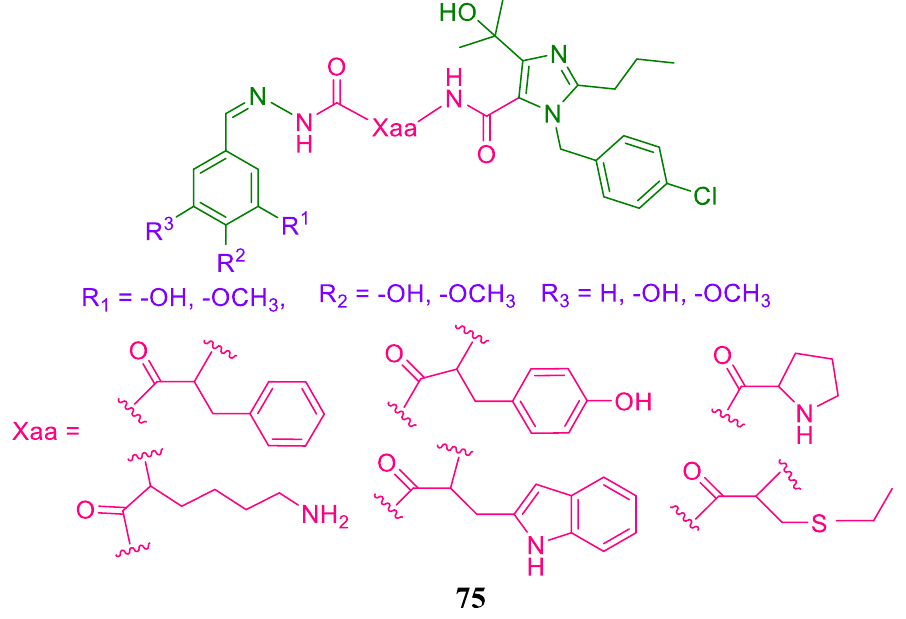
Figure 61. Amino acids – imidazole